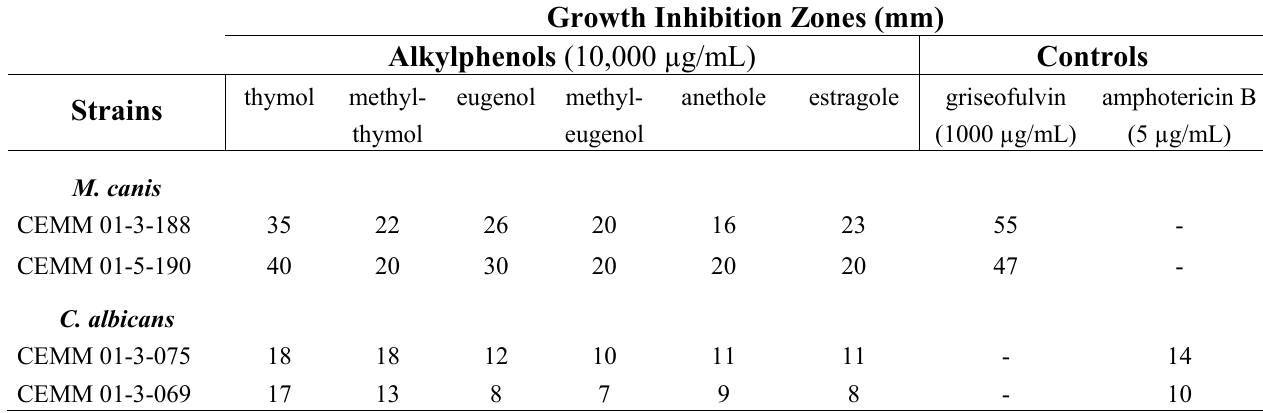
Table 1. Screening of antifungal activity of alkylphenols against M. canis and Candida spp. by the agar-well diffusion method. Growth Inhibition Zones (mm) Alkylphenols (10,000 µg/mL) Controls thymol methyl- eugenol methyl- anethole estragole griseofulvin amphotericin B Strains thymol eugenol (1000 µg/mL) (5 µg/mL) M. canis CEMM 01-3-188 35 22 26 20 16 23 55 - CEMM 01-5-190 40 20 47 - C.